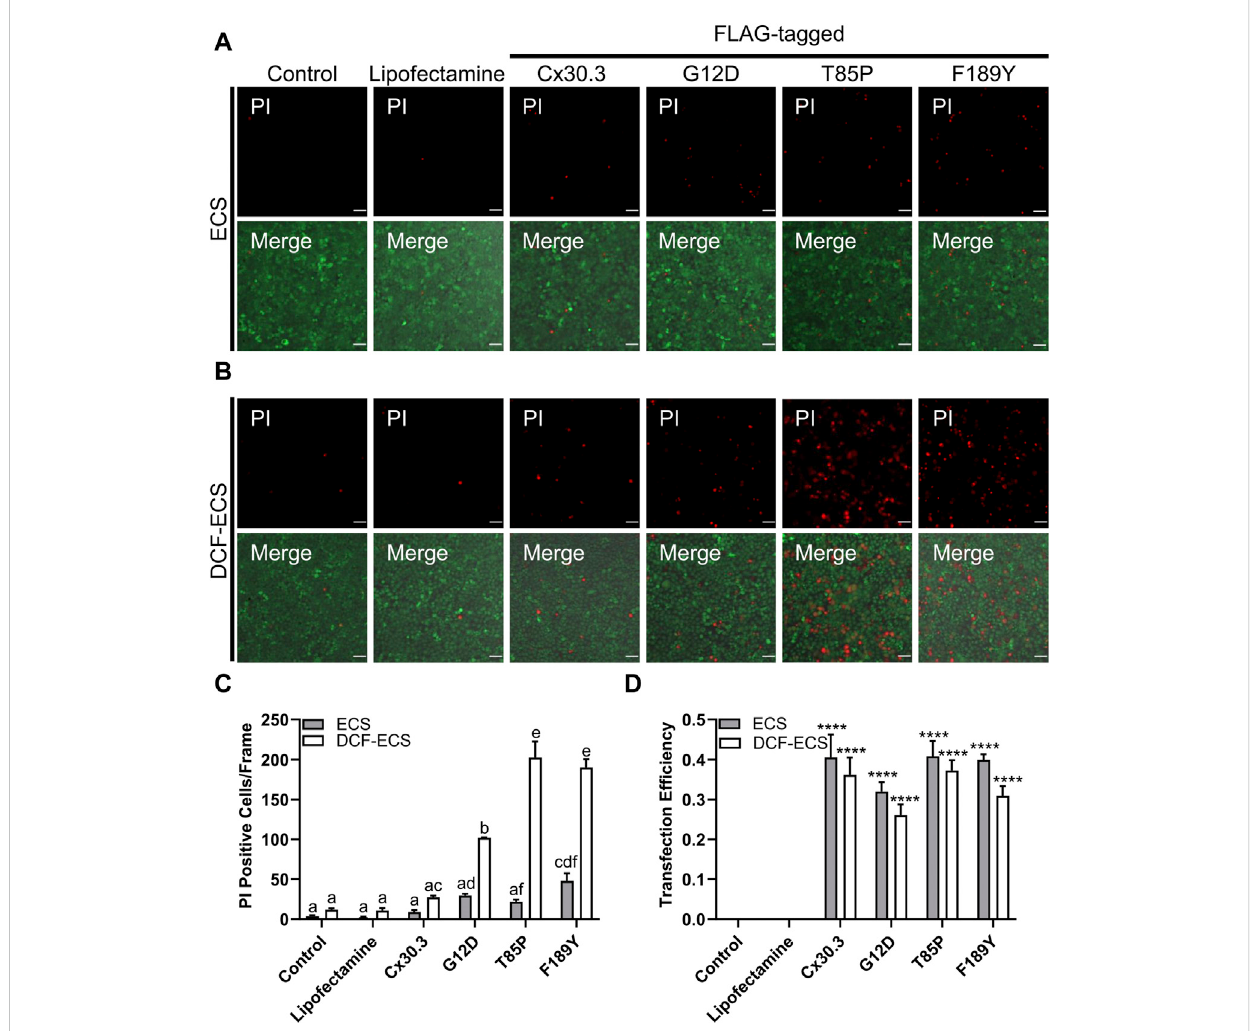
FIGURE 7 Mutant expressing keratinocytes are more permeable to propidium iodide. Representative images of Cx43KO REKs expressing FLAG-tagged wild type or Cx30.3mutantsand loaded with propidium iodide (PI; red) and calcein AM (green) in either (A) extracellular solution (ECS) containing the divalent cations Ca 2+ and Mg 2+ or (B) divalent cation-free extracellular solution (DCF-ECS). (C) Quanti fi cation reveals that signi fi cantly more cells expressing Cx30.3 mutants took up PI in the absence of divalent cations compared to both of the controls and wild type Cx30.3 in both ECS (grey bars) and DCF-ECS (white bars) conditions. Groups marked with the same letter are not signi fi cantly different from one another. (D) Parallel quanti fi cation of transfection ef fi ciency reveals that a similar proportion of cells expressed Cx30.3 across all conditions. **** p < 0.0001 compared to control and lipofectamine groups in the same extracellular